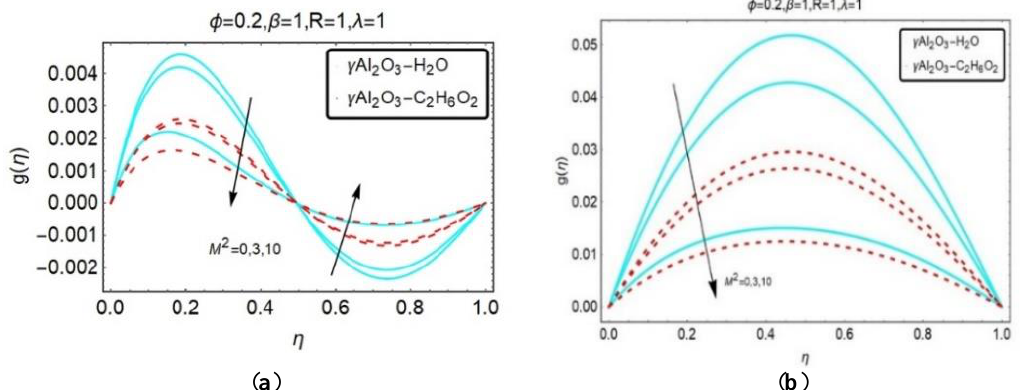
Figure 13. Influence of 𝑀 2 on 𝑔(𝜂) for ( a ) 𝑆 > 0 and ( b ) 𝑆 < 0.